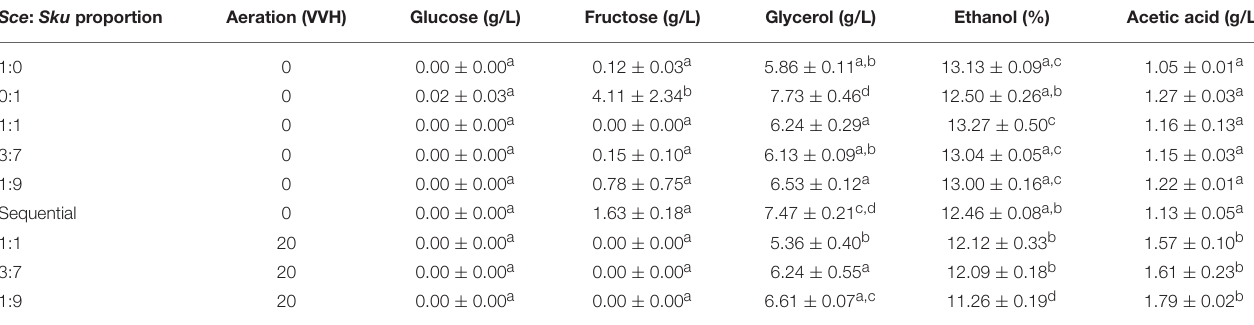
Values are given as mean ± standard deviation of three biological replicates and two HPLC detection runs. An ANOVA analysis was carried out. The values followed by different superindexes in the same column are significantly different according to the Tukey HSD test ( α =